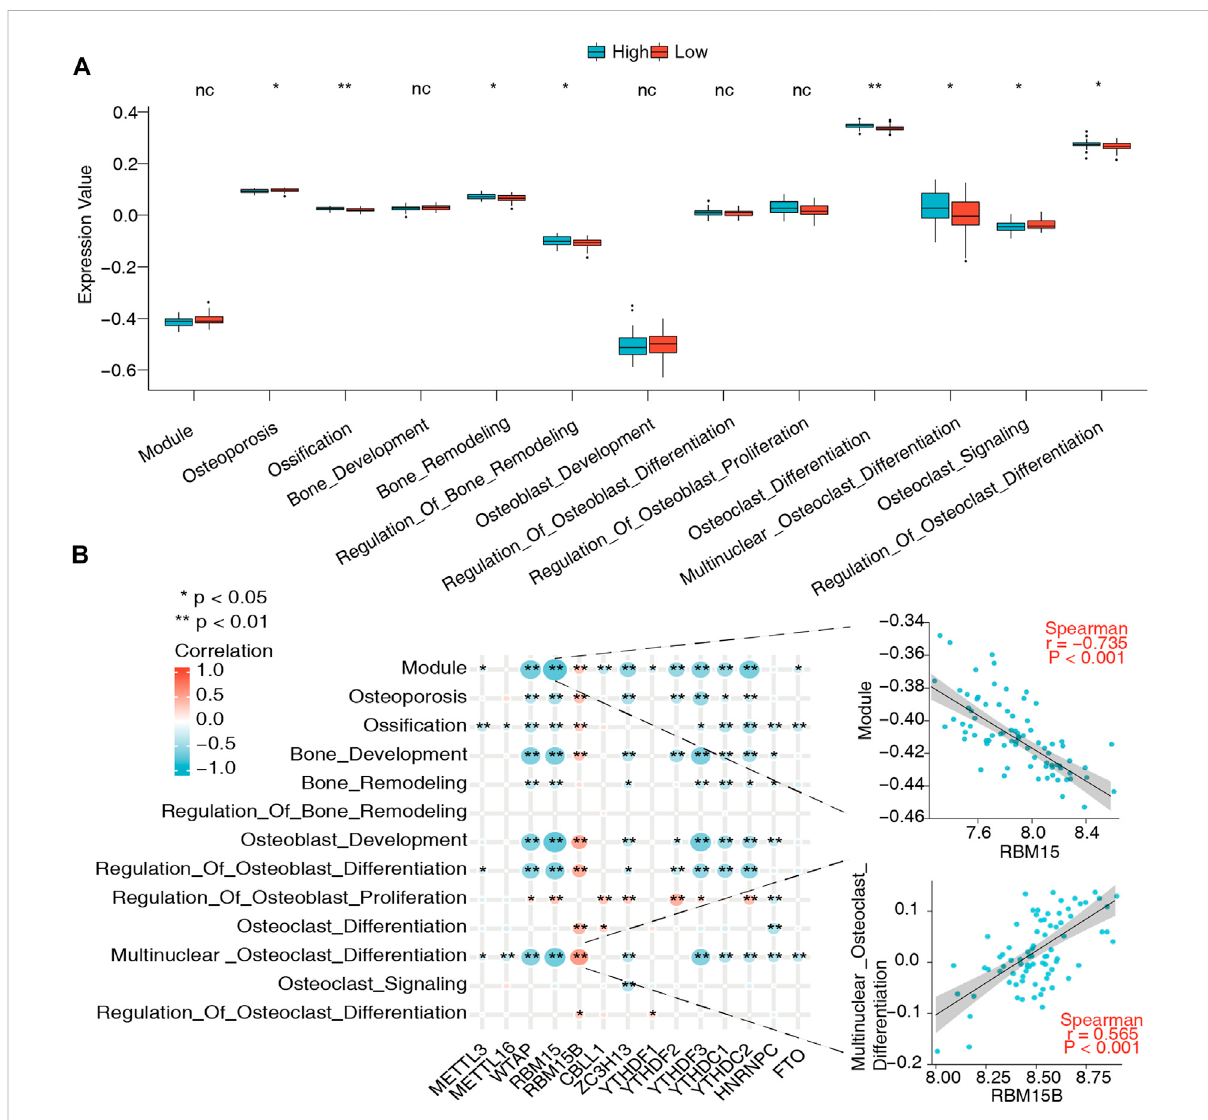
Relationship between bone metabolism-related gene sets and m6A regulators. (A) Differences in abundance and activity of bone metabolism- related gene sets in the high- and low-BMD groups. (B) Expression correlations of these bone metabolism-related gene sets and m6A regulators in allsamples.Signi fi cantly,the RBM15 -modulepairwasthemostnegativelycorrelated,theexpressionstatusofwhichispresentedinthescatterplotin the upper right panel, while the RBM15B -multinuclear osteoclast differentiation pair was the most positively correlated with expression status presented in the scatter plot in the lower right